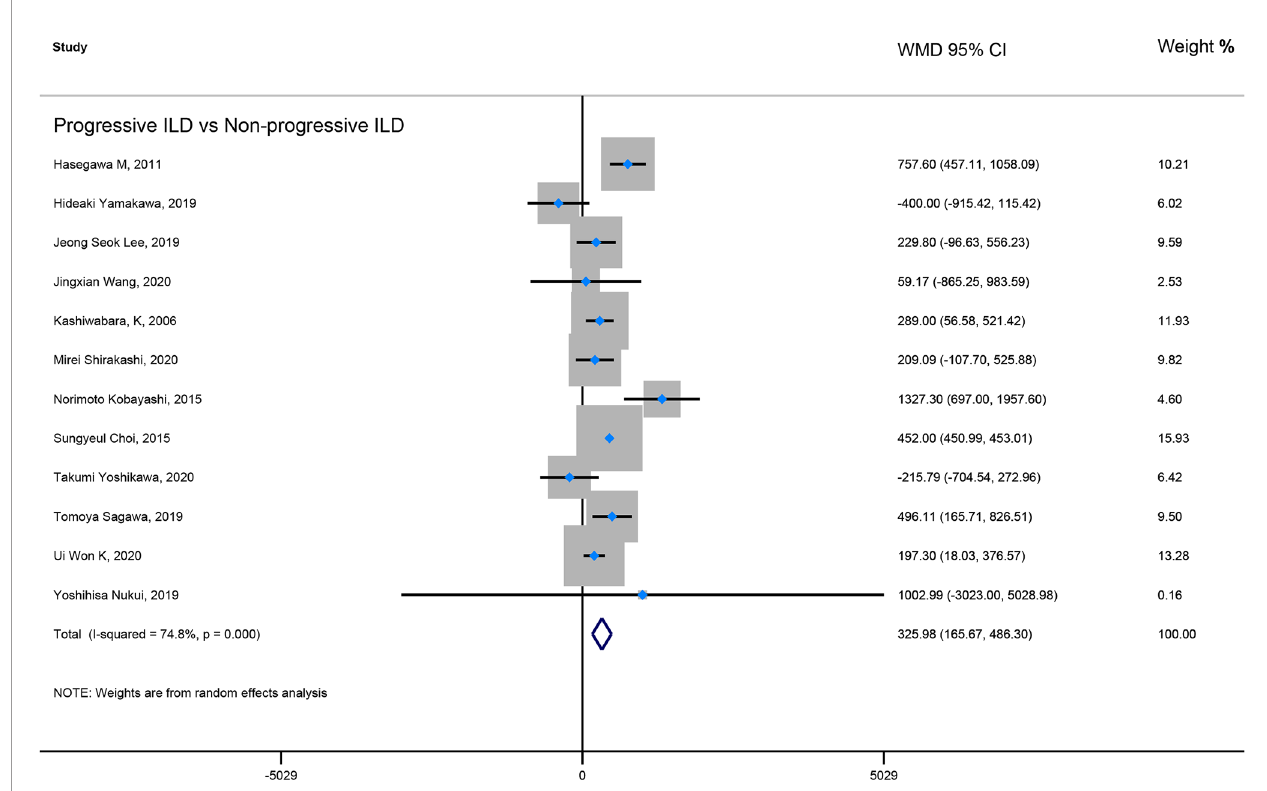
FIGURE 3 | The forest plot illustrated the WMD (95%CI) of KL-6 level between progressive ILD and non-progressive